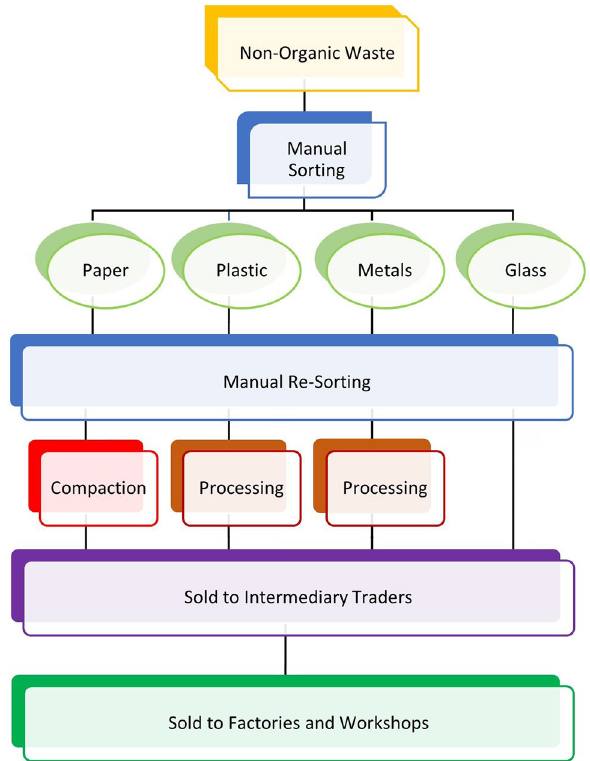
Fig. 2 Waste sorting and